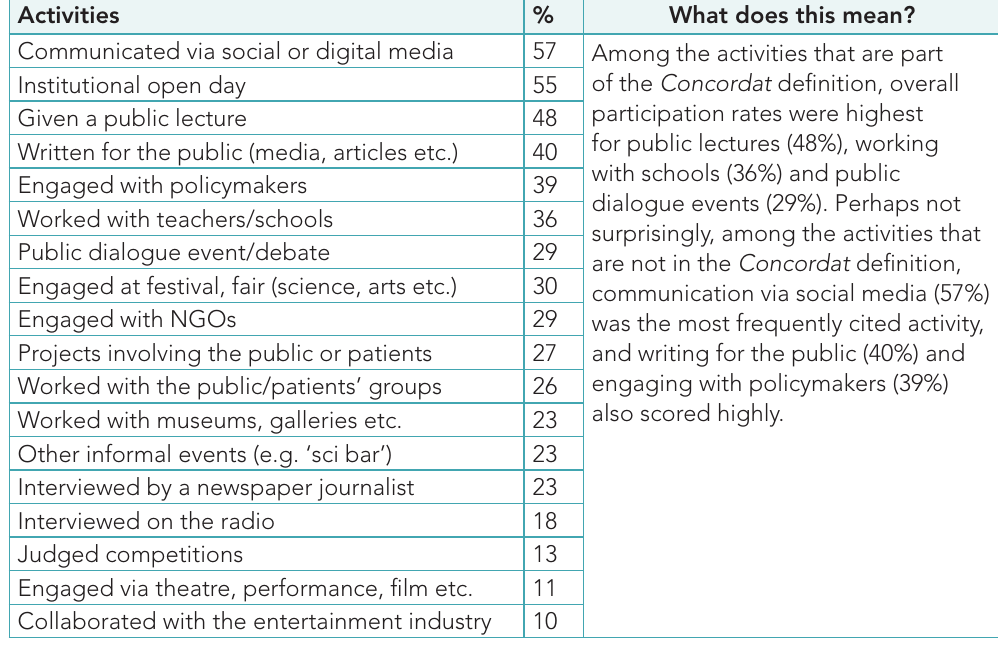
Table 1: Participation in public engagement and communication